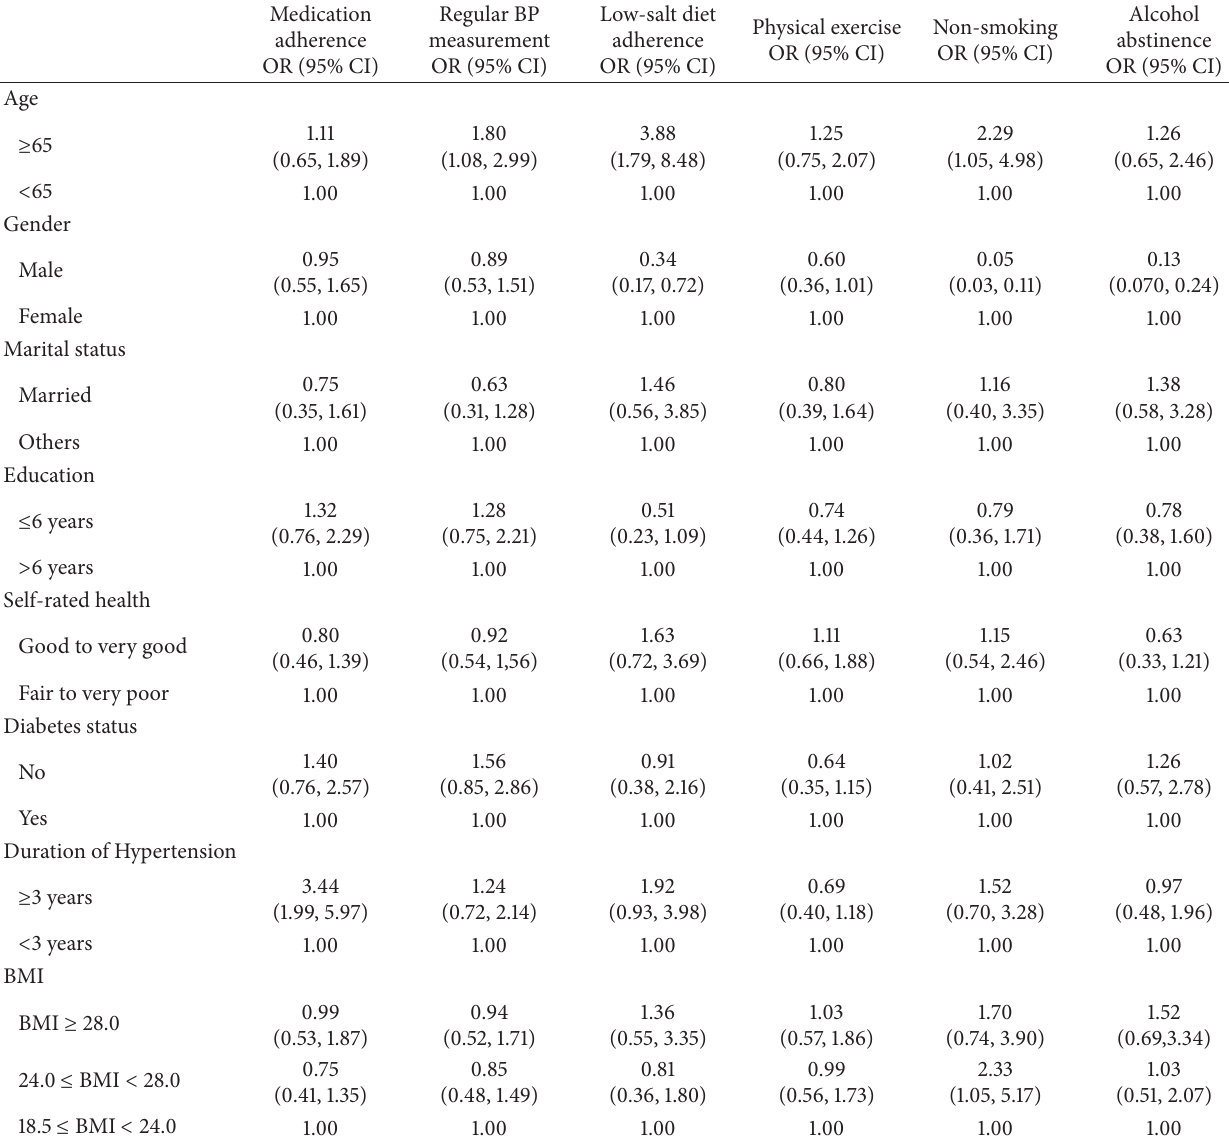
Table 3: Associations between demographic and health characteristics and hypertension self-care behaviors in a rural hypertension population in Beijing,